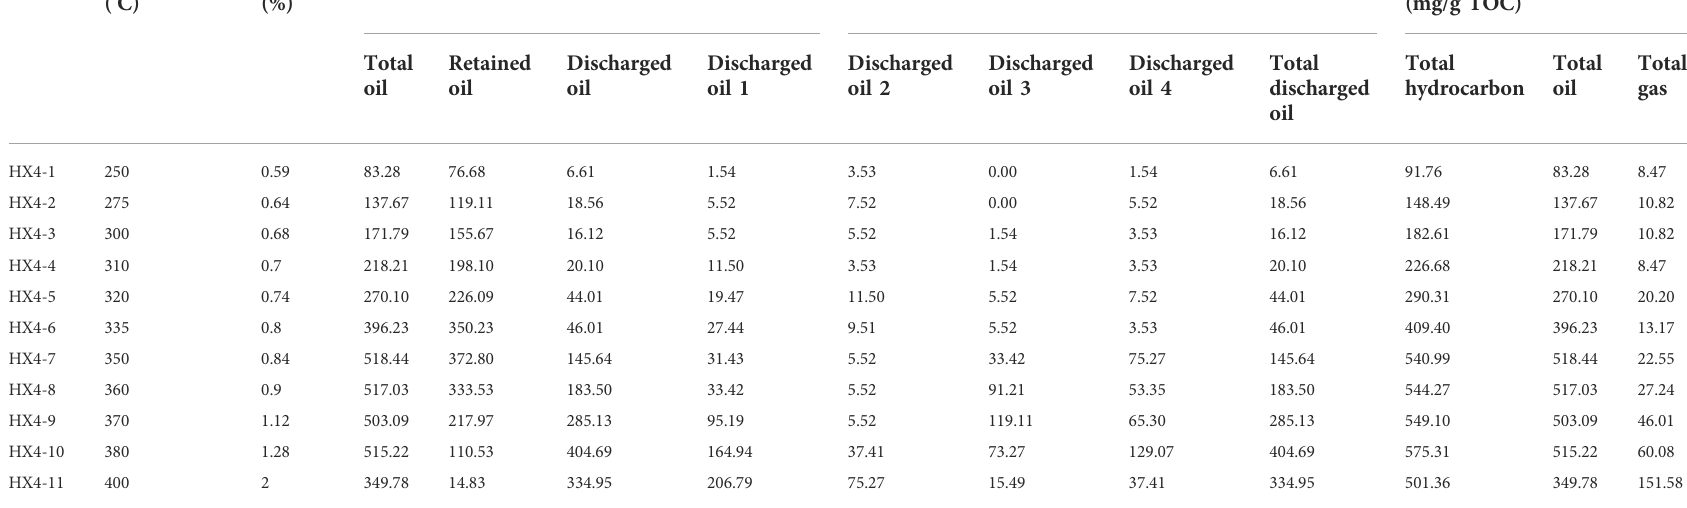
TABLE 4 Retained and discharged oil yields of model 1.